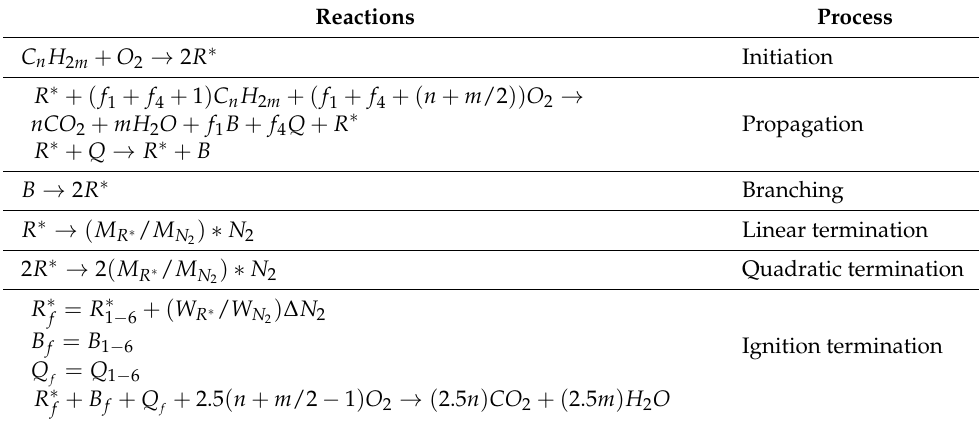
Table 5. Modified Shell ignition reaction mechanism used in the simulations.